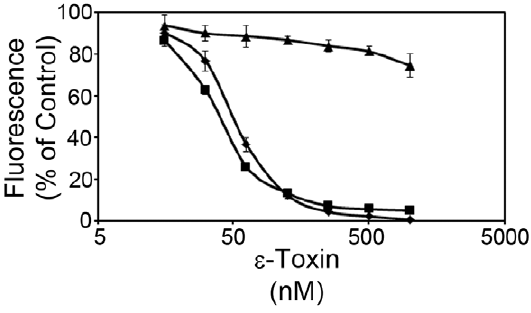
Figure 5. e -toxin-induced cytotoxicity in caveolin-1-deficient cells. ACHN cells ( X ), ACHN cells stably transfected with a non- targeting control shRNA (NTC) ( & ), or ACHN cells stably transfected with CAV1 -specific shRNA (CAV1 – 48) ( m ) were incubated with serial dilutions (15.6 to 1000 nM toxin) of purified e -toxin at 37 u C. Cell viability was assessed as described in the Materials and Methods. Results represent the mean and standard deviation of quadruplicate samples. We did not determine the dose of toxin needed to kill 50% of cells as completing the dose response curve for cells transfected with CAV1 - shRNA would require considerable amounts of